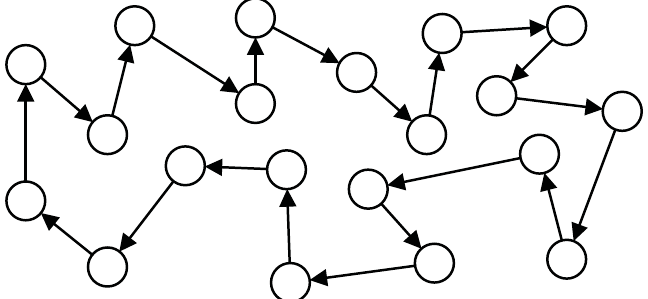
Figure 2. Network topology consisting of K = 20 agents with ring topology.